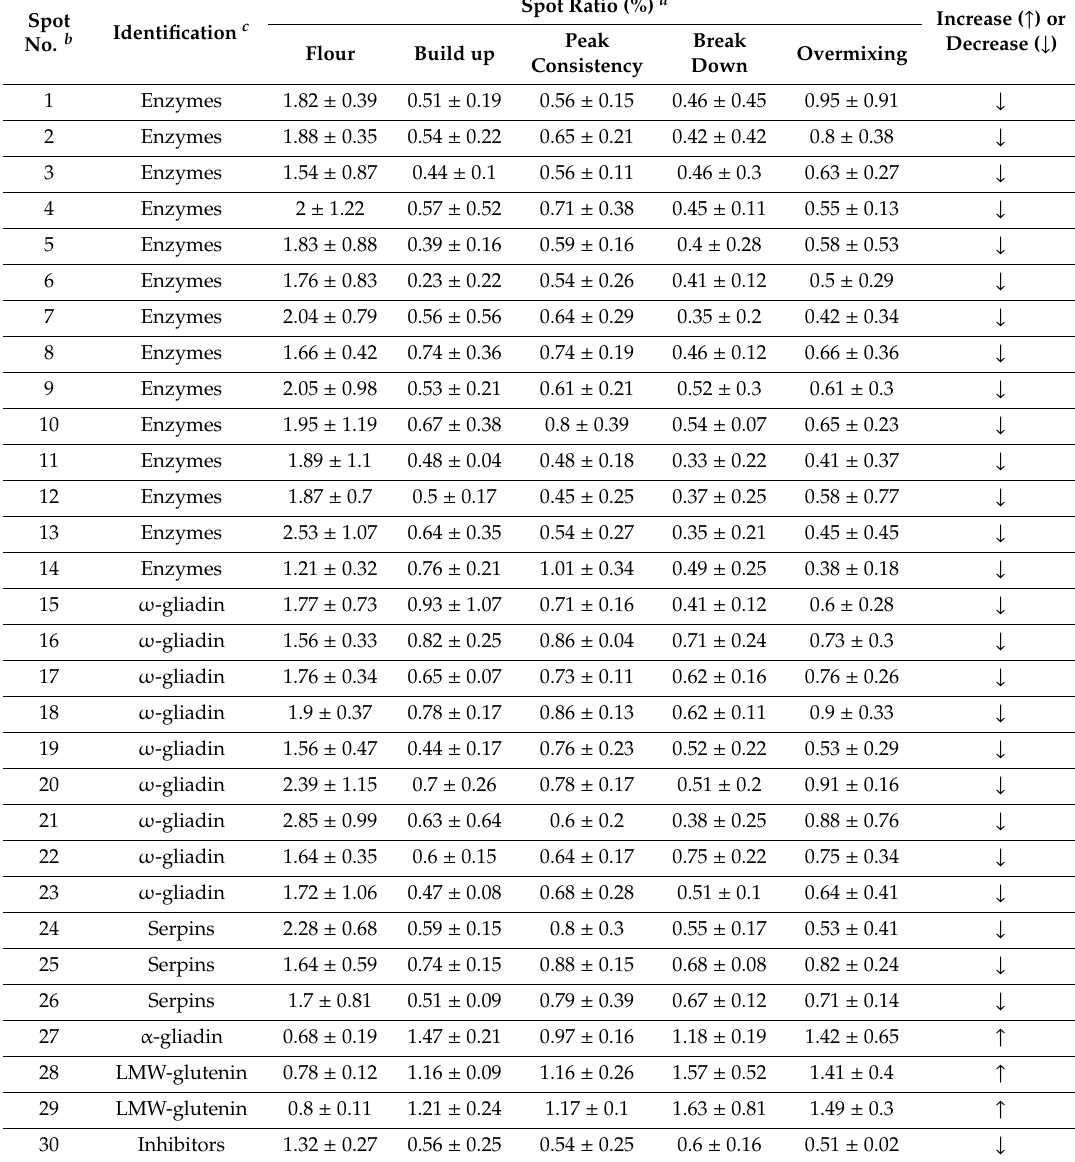
Table 2. Decreased and increased proteins in monomeric protein in HF a during mixing. Spot No.